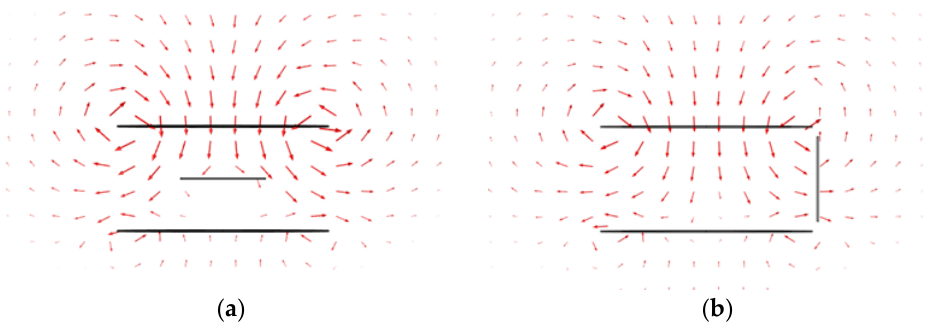
Figure 5. The distribution of the magnetic field; ( a ) with the parallel plate; ( b ) with the vertical plate.